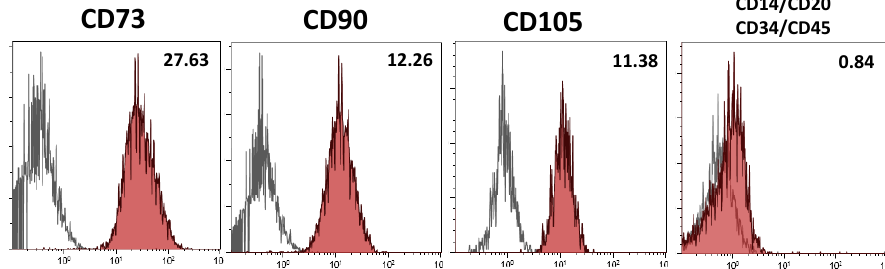
Figure 2. Immunophenotypic characterization of h DPSCs by flow cytometry for the expression of mesenchymal (CD73, CD90 and CD105) and hematopoietic (CD14, CD20, CD34 and CD45) stem cell (SC) markers (grey histogram: unstained control, red histogram: marker of interest). Results are means of triplicates of three independent experiments.